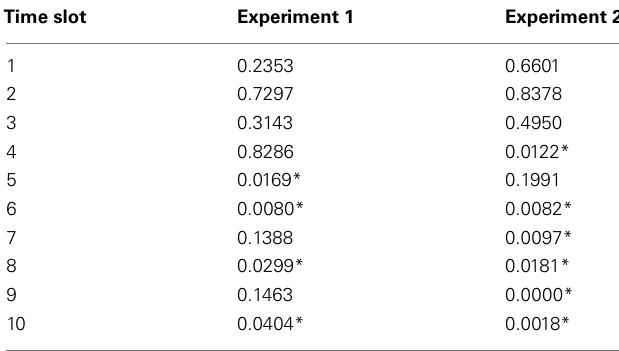
Table 2 |Analysis of eye tracking data from the first premise of all filler